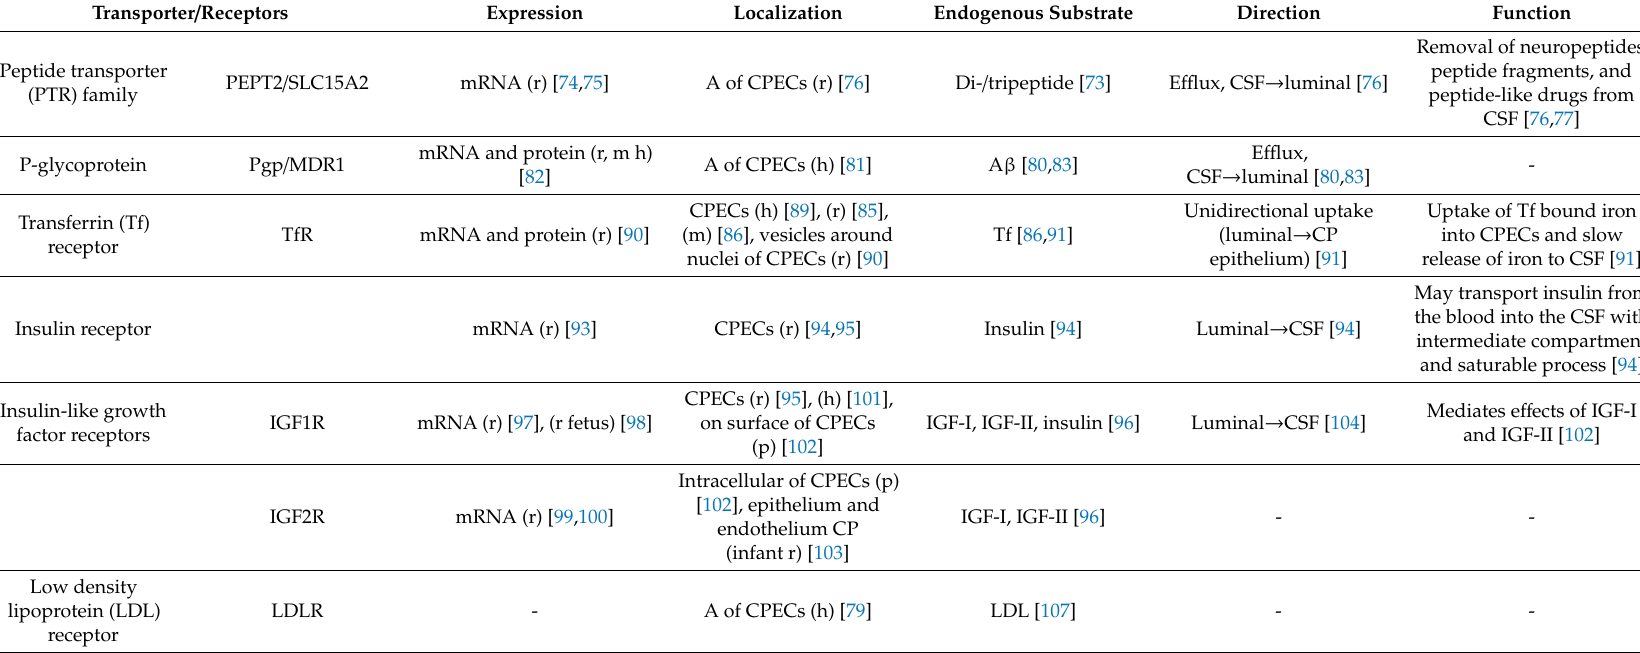
Table 1. Summary of transporters and receptors involved in transport of peptides and proteins at blood–cerebrospinal fluid (CSF) barriers